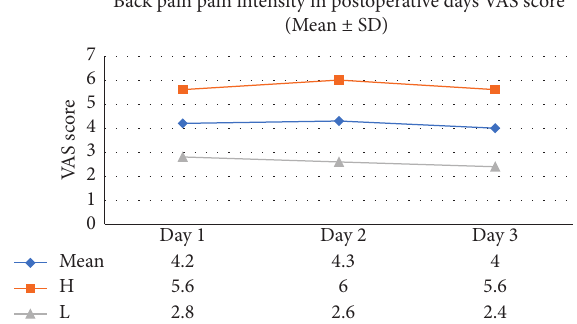
Figure 2: Severity of back pain on the three postoperative days at the University of Gondar Comprehensive and Specialized Hospital, North West Ethiopia, from March to May 2020 ( n � 87).